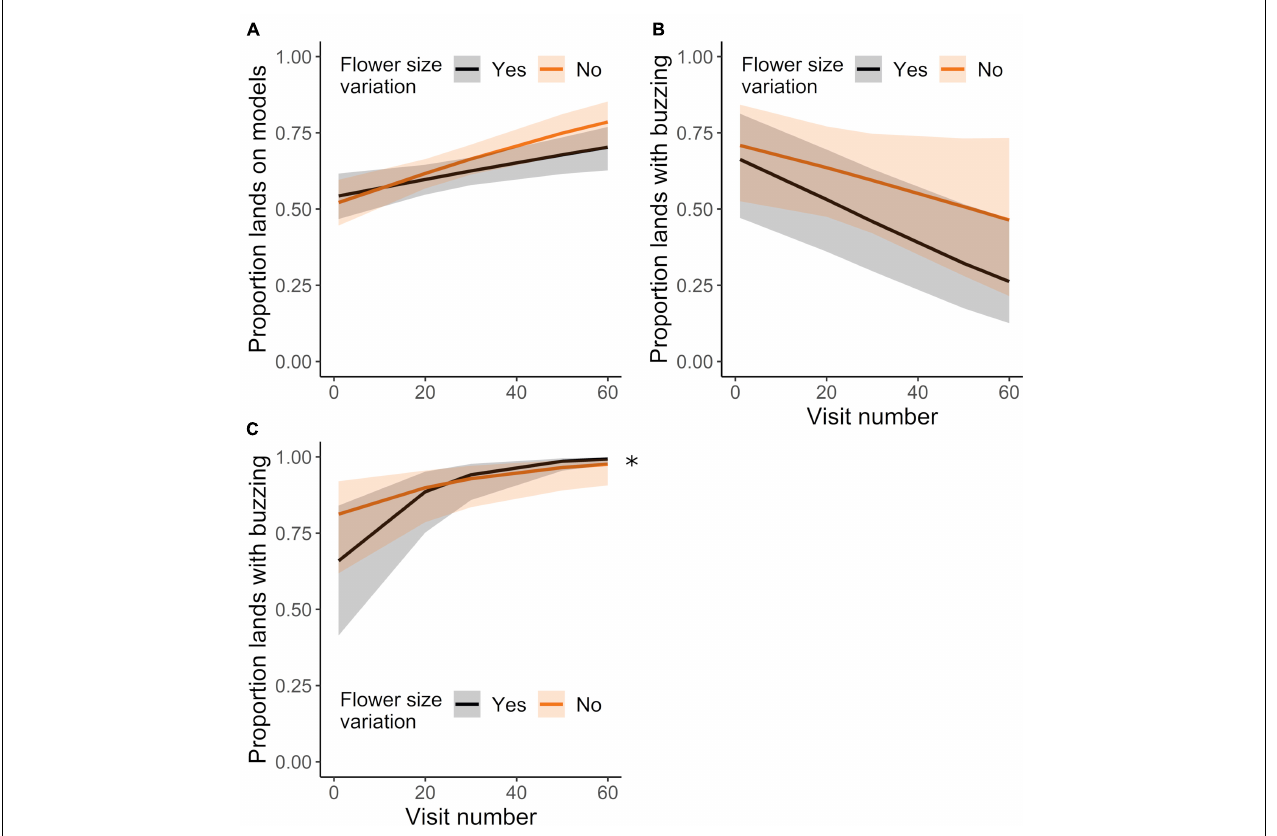
FIGURE 6 | Landing behavior of initially-naïve bees (same dataset as in Figures 5B–D , analyzed for different sampling behavior) foraging in the control or corolla size variation treatments. Mean proportion of lands made on (A) models (vs. mimics), (B) mimics during which the bee buzzed, and on (C) models during which the bee buzzed, over the course of up to 60 landings. N = 15 and 18 bees in the control and variation treatment, respectively. Plotted lines indicate estimated means and shaded regions indicate 95% confidence intervals. Asterisk indicates a significant difference among treatments at P <